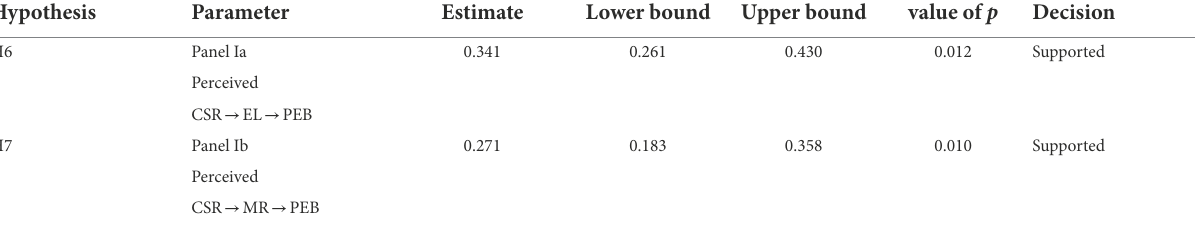
TABLE 9 Standardized mediation effects: parameter estimate and bootstrap percentile method confidence